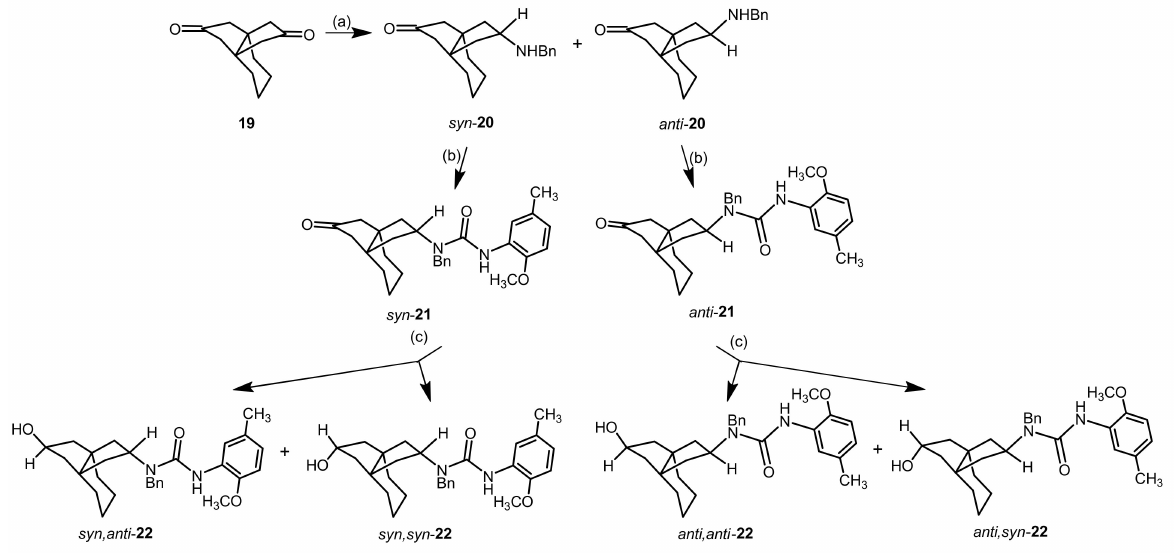
Scheme 3. Synthesis of N -benzylurea derivatives 21 and 22. Reagents and reaction conditions: (a) C 6 H 5 CH 2 NH 2 (BnNH 2 ), NaBH(OAc) 3 , HOAc, ClCH 2 CH 2 Cl, rt, 96 h, 16% ( syn - 20 ), 9% ( anti - 20 ). (b) 2-Methoxy-5-methylphenyl iso- cyanate, Bu 2 Sn(OAc) 2 , THF, rt, 18 h, 70% ( syn - 21 ), 82% ( anti - 21 ). (c) NaBH 4 , CH 3 OH, THF, rt, 30 min, 43% ( syn,anti - 22 ), ( syn,syn - 22 ), 33% ( anti,anti - 22 ) and 38% ( anti,syn - 22 ). The N -benzylurea derivatives anti - 21 , syn,anti - 22 and anti,syn - 22 were crystallized from EtOAc, leading to crystals suitable for X-ray crystal structure analysis. (Figures 6–8).